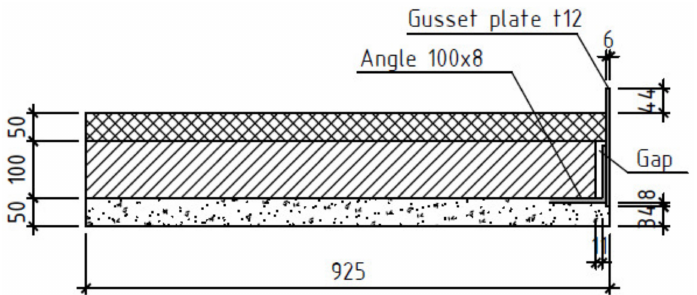
Figure 17. Calculation scheme with a gusset plate. Partial filling of the gap with thermal insulation between precast concrete elements and metal structures (units: mm). Table 5. The length of the condensation area along the perimeter of the section of the bottom chord of the truss, depending on the temperature and relative humidity of the air in the attic (calculation scheme with a gusset plate: partial filling of the gap with thermal insulation between precast concrete elements and metal